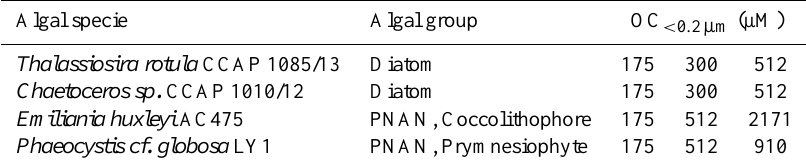
Table 2. Algal species employed for the production of exudate and OC < 0 . 2 µ m of seawater proxies prepared with a single algal exudate.